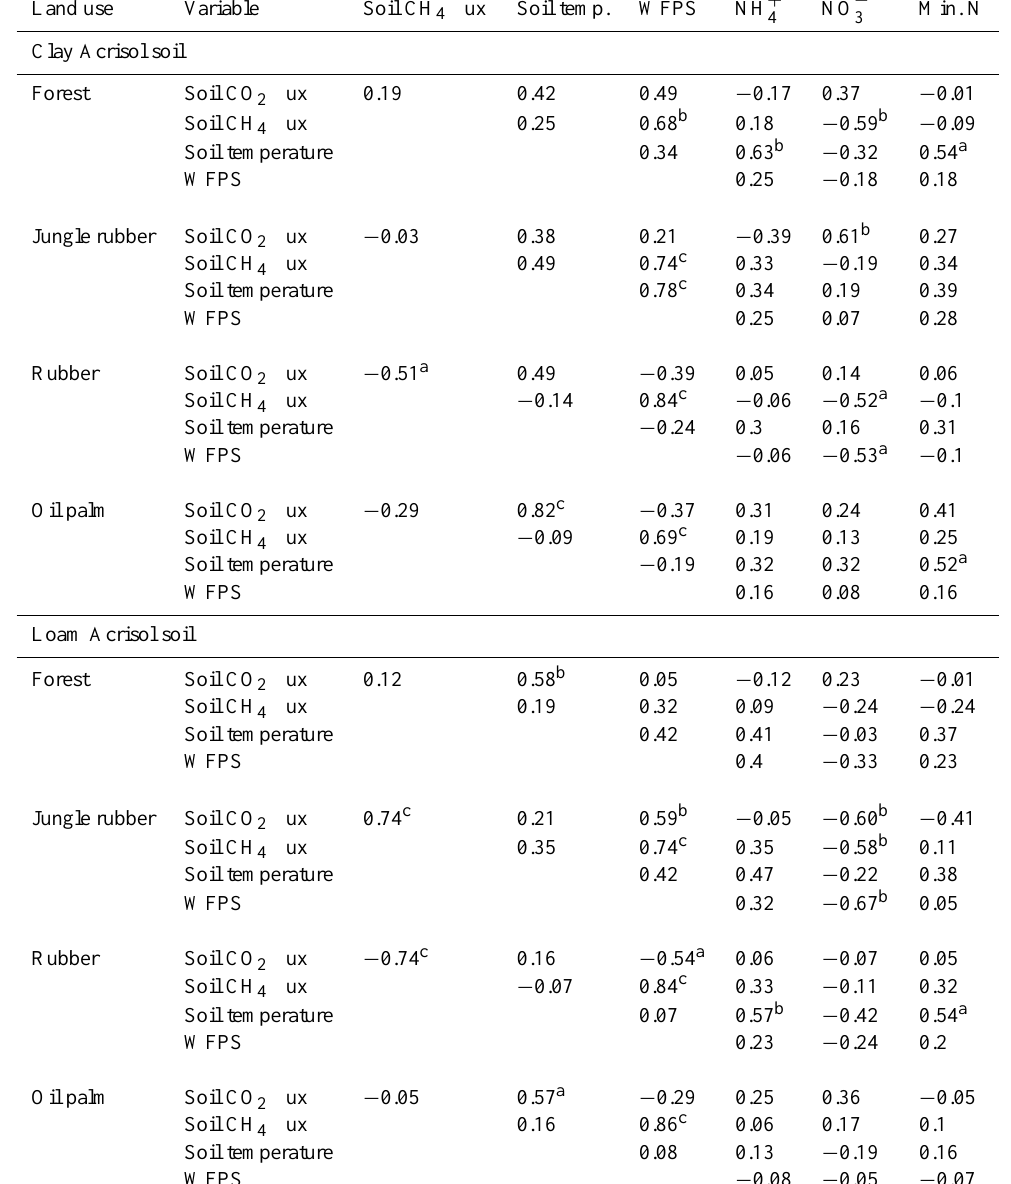
Table 3. Pearson correlation coefficients ( n = 12) between soil CO 2 flux (mg Cm − 2 h − 1 ), soil CH 4 flux (µg Cm − 2 h − 1 ), soil temperature ( ◦ C, top 0.05m depth), water-filled pore space (WFPS) (%, top 0.05m depth) and extractable mineral nitrogen (mg N kg − 1 , top 0.05m depth), using the monthly-measurement means of the four replicate plots per land-use type between December 2012 and December